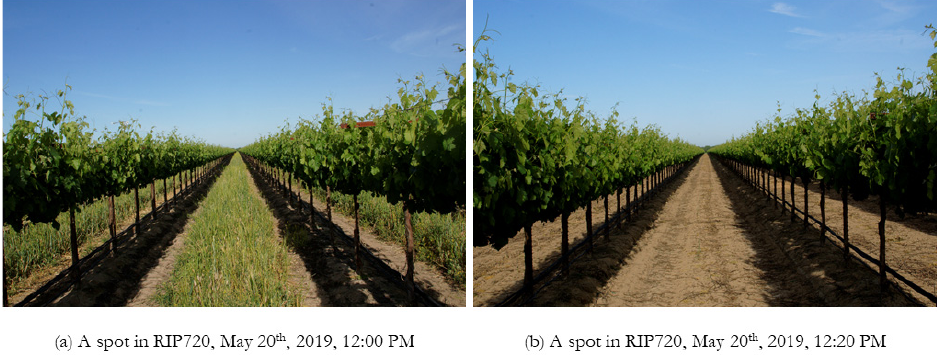
Figure 9. Two examples, ( a , b ), show the different interrow under the vine canopy.